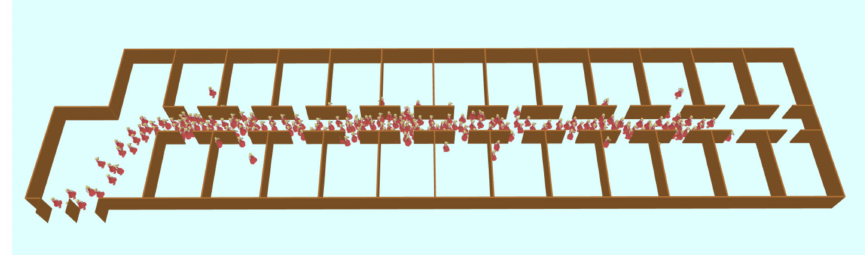
Figure A11. The evacuation